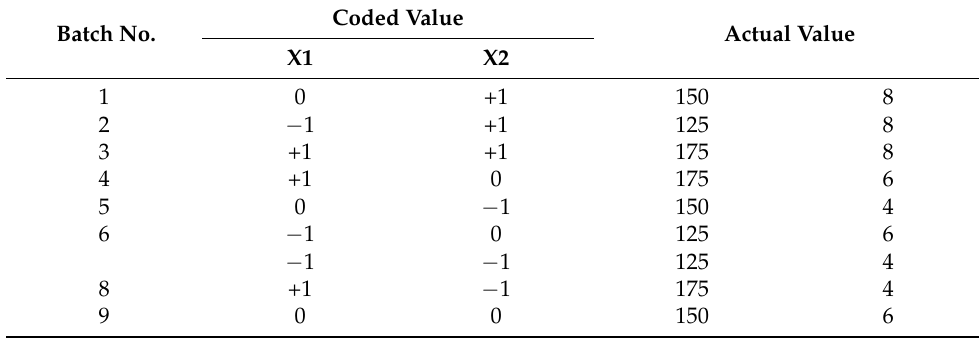
Table 4. Coded and actual values for 9 batches of the 3 2 full factorial design. Batch